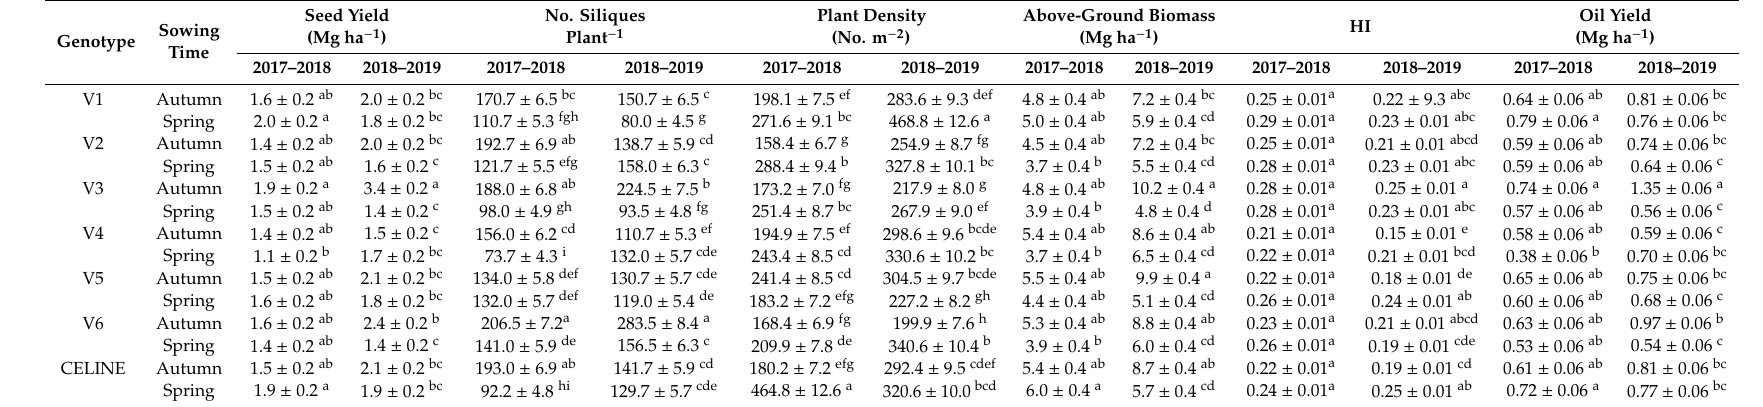
Table 4. The interaction e ff ects of genotype and sowing time for each growing season on camelina yield and yield components. Sowing Genotype